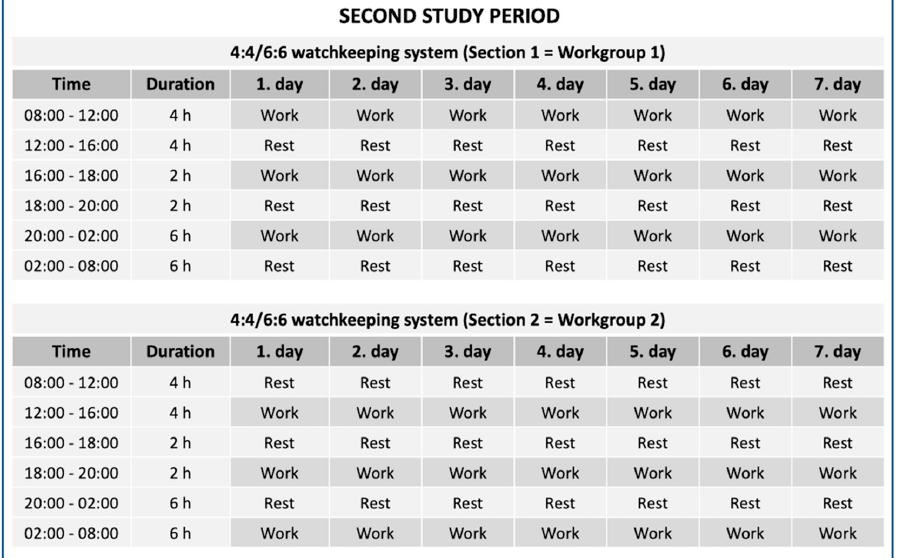
Figure 2. The structure of the two Section 4:4/6:6 watchkeeping system during the second study period.